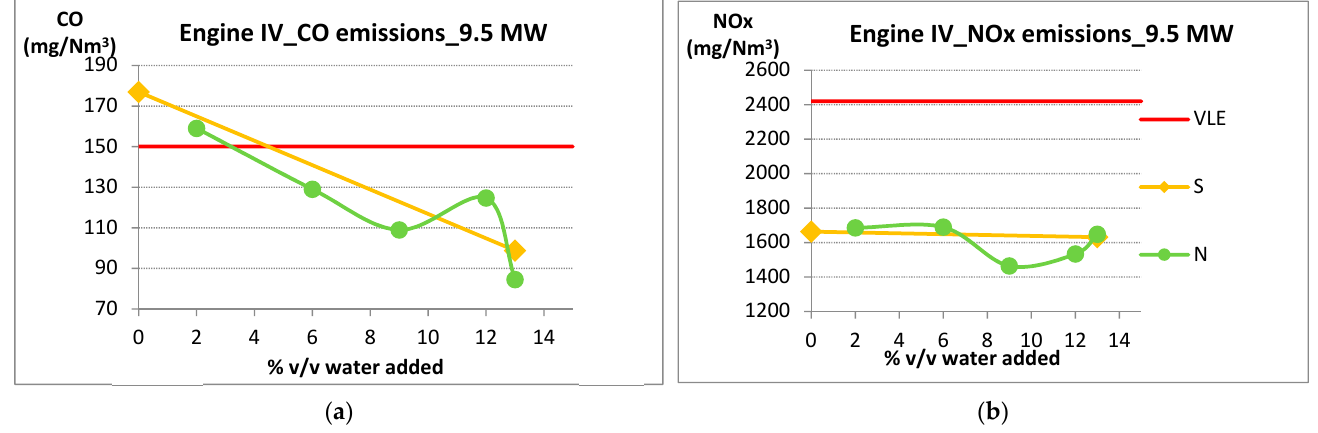
Figure 31. Engine IV: emissions measured at 8.5 MW SP power with variable % W/F emulsions. ( a ) CO emissions; ( b ) NOx emissions.